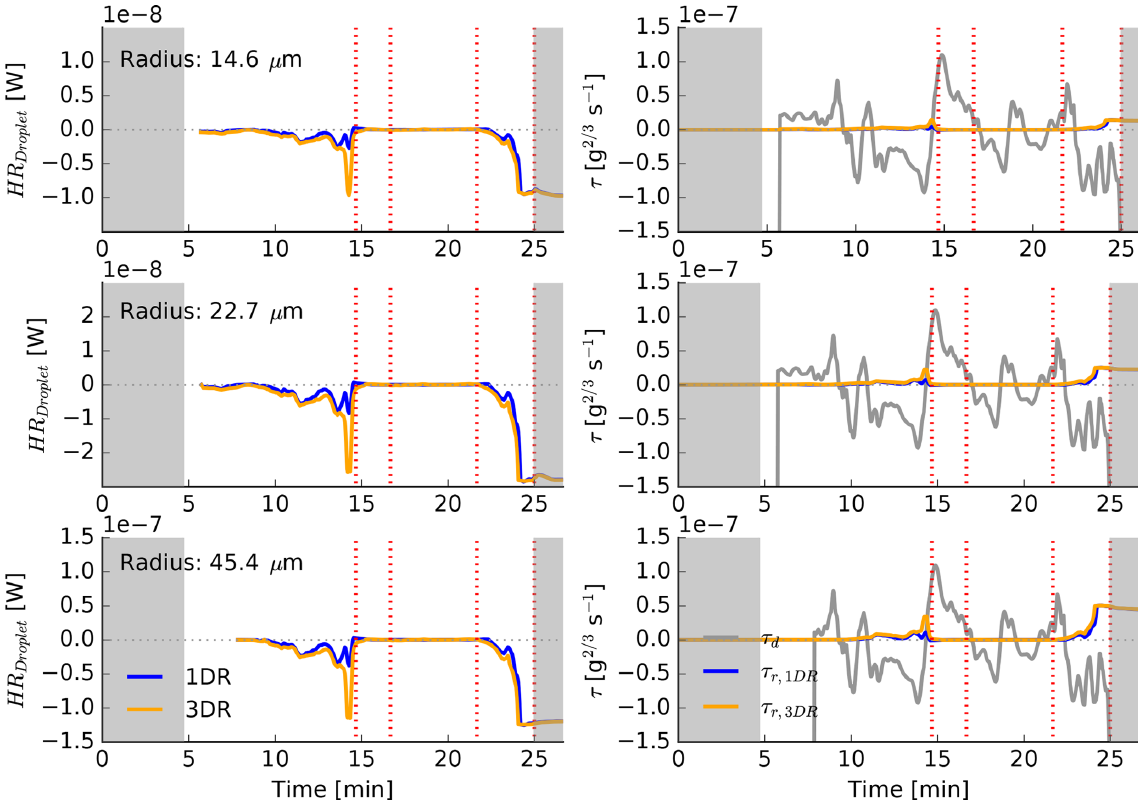
Figure 7. Wavelength integrated, bin-resolved heating or cooling rates and forcing τ d and τ r